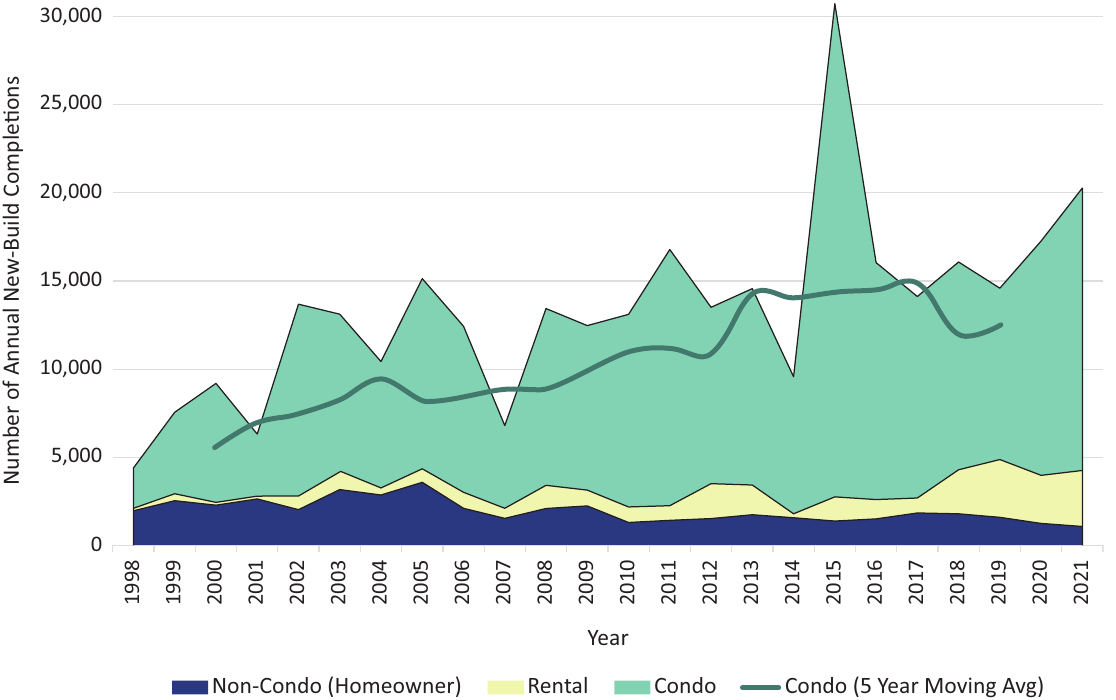
Figure 1. New build housing completions by intended market in the City of Toronto, 1998–2021. Source: Calculated by the authors using data from CMHC (2022).